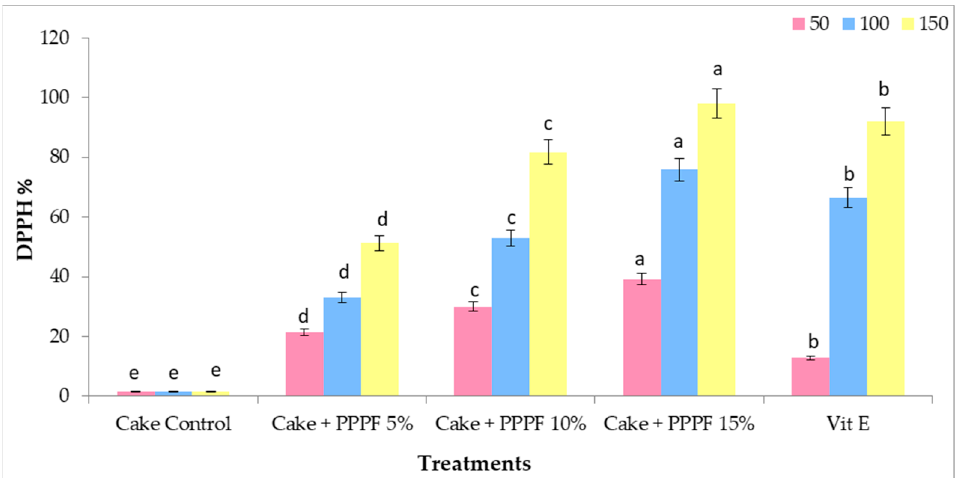
Figure 5. Antioxidants capacity % of cake prepared by replacing flour with various levels of prickly pear peel flour (50, 100, and 150 µg/mL of PPPF) against DPPH. Each value represents the mean (±SD) of three different replications. Different letters on the same bar show a significant difference according to Duncan’s test at p ≤ 0.05.